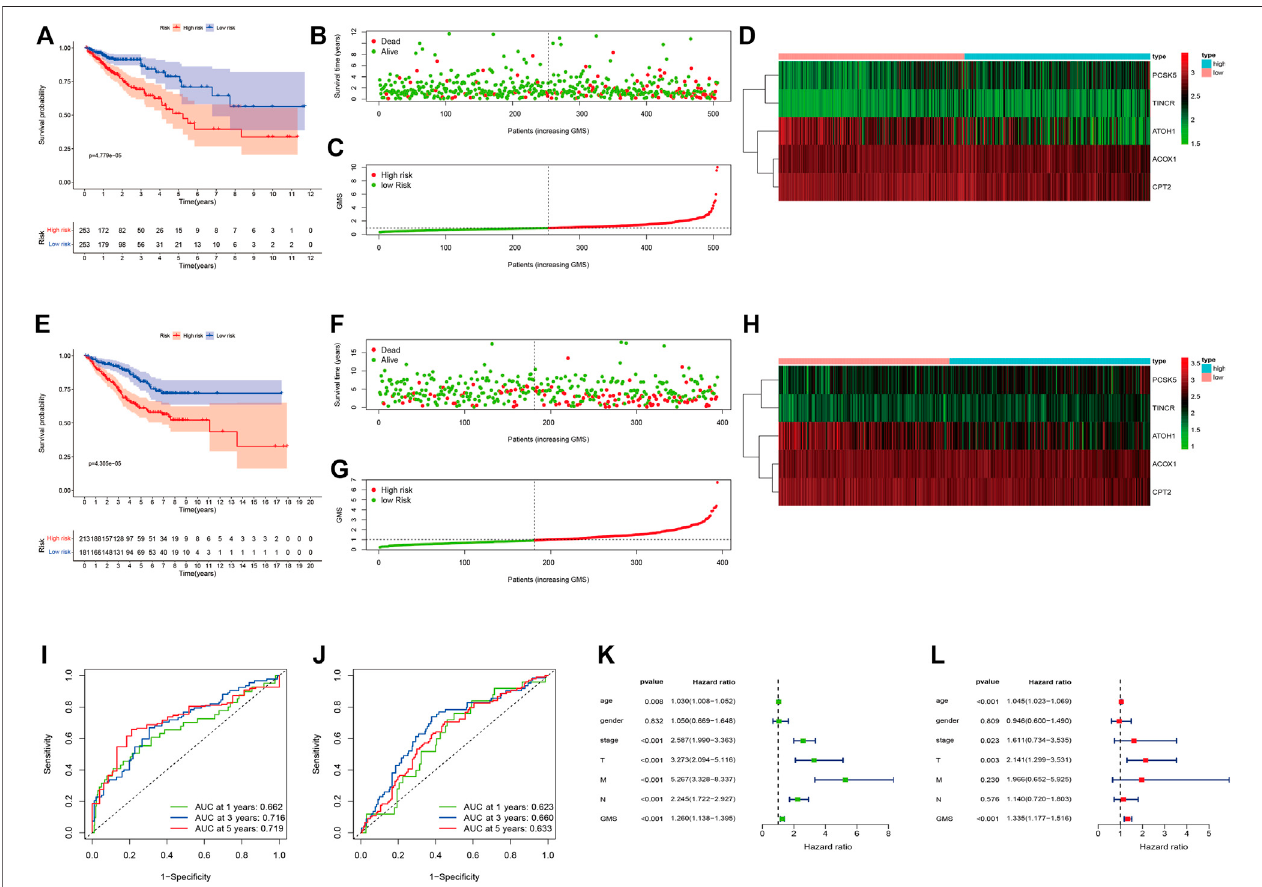
FIGURE6| CRCpatientsstrati fi edaccordingtothe fi ve-GMRHGprognosticsignature. (A – D) :ThesurvivalplotsfortheTCGACRCpatientsrespectivelyillustrating theoverallsurvivaldifference,thedistributionofGMS,thesurvivalstatusofCRCpatients,andtheexpressionvariationsof fi veGMRHGsinthehigh-andlow-riskgroups. (E) – (H) : The survival plots for the GEO CRC patients (GSE17536, GSE38832 and GSE103479) respectively illustrating the overall survival difference, the distribution of GMS, the survival status of CRC patients, and the expression variation of fi ve GMRHGs in the high- and low-risk groups. (I,J) : The one-, three-, and fi ve-year ROC curves of the fi ve-GMRHG prognostic signature based on the training and test group. (K,L) : The univariate and multivariate independent prognostic analysis.